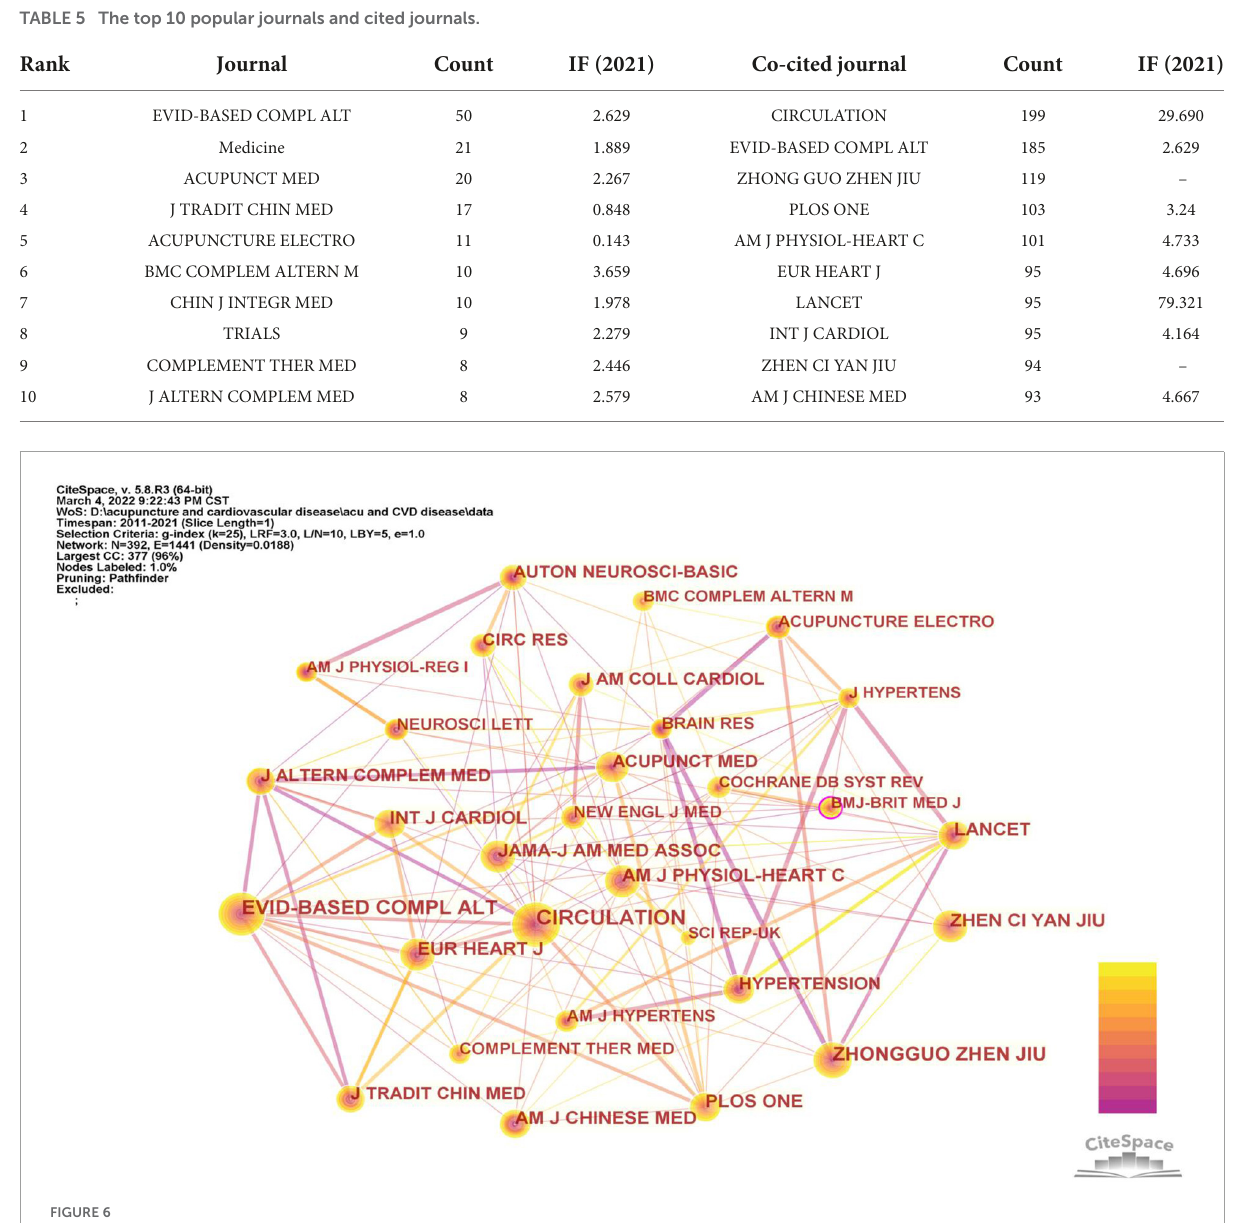
FIGURE6 Network map of co-cited journals about acupuncture on